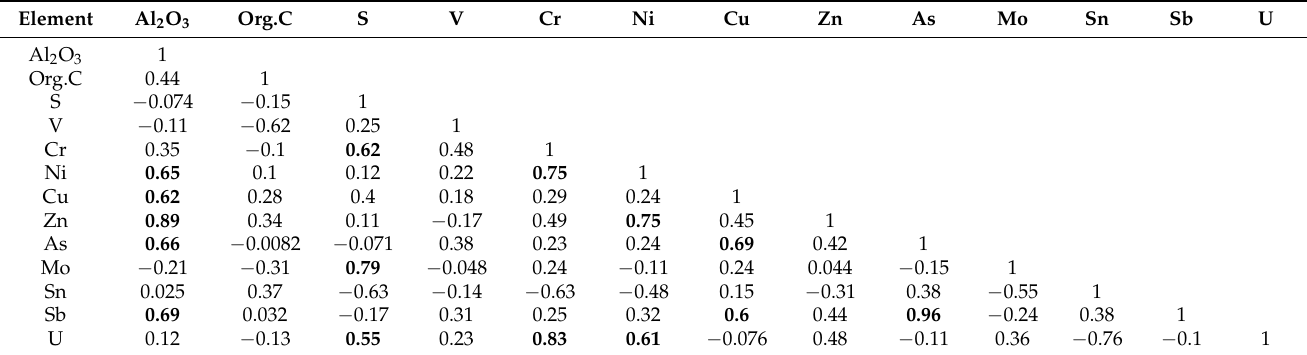
Table 5. Correlation coefficients between alumina, organic carbon, and trace elements in the black mudstones. Element Al 2 O